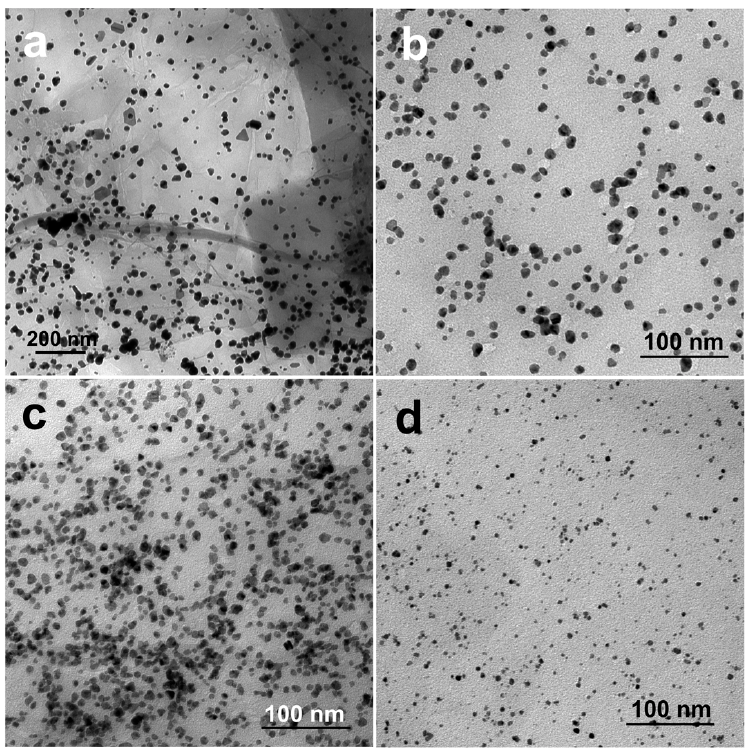
Figure 4. TEM images of the ( a ) Pd/rGO3500-1; ( b ) Pd 3 Pt 1 /rGO3500-1; ( c ) Pd 1 Pt 1 /rGO3500-1; and ( d ) Pt/rGO3500-1